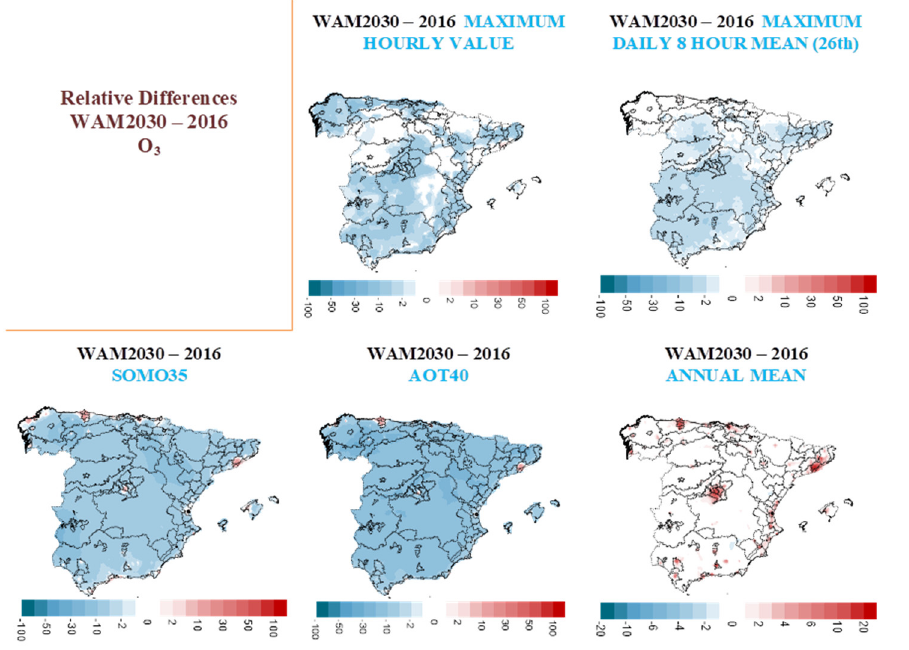
Figure 8. Relative difference (%) maps between the WAM2030 scenario and the reference case 2016 for different O 3 metrics.